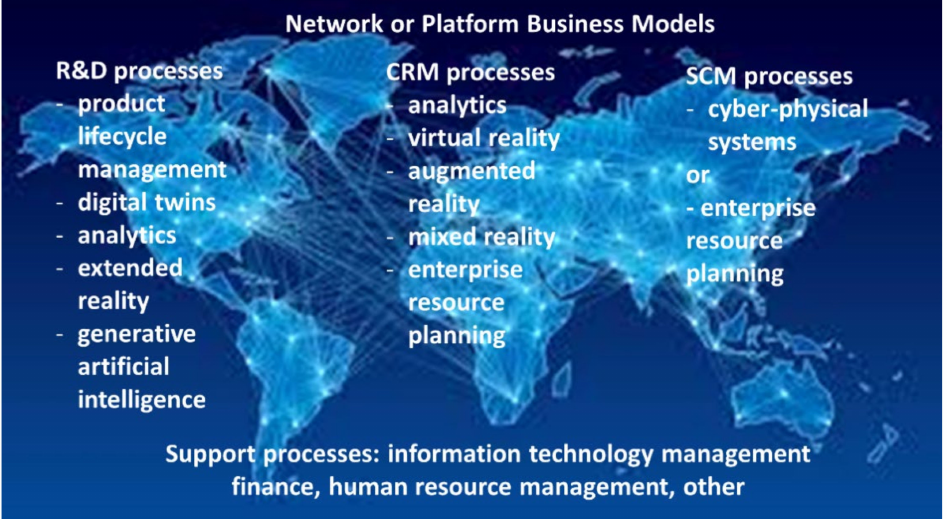
Figure 2. Technologies and supporting processes in network business